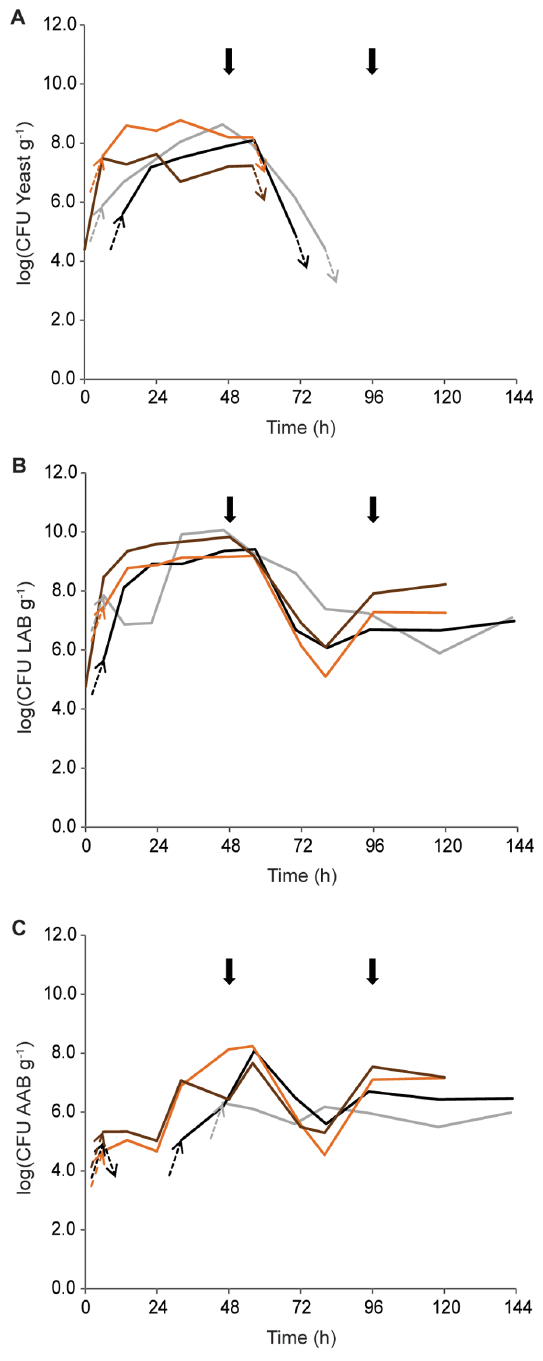
Figure 1. Microbial cell counts during four Malaysian sponta- neous cocoa pulp fermentations. A: yeast. B: lactic acid bacteria (LAB). C: acetic acid bacteria (AAB). Box fermentation 1 (October 2011, black), heap fermentation 1 (October 2011, grey), box fermentation 2 (January 2012, brown) and heap fermentation 2 (January 2012, orange). The dashed arrows indicate when the cell counts rise up to or drop below the detection limit [1.5 10 4 colony forming units (CFU) g 2 1 ]. Solid arrows indicate turning.